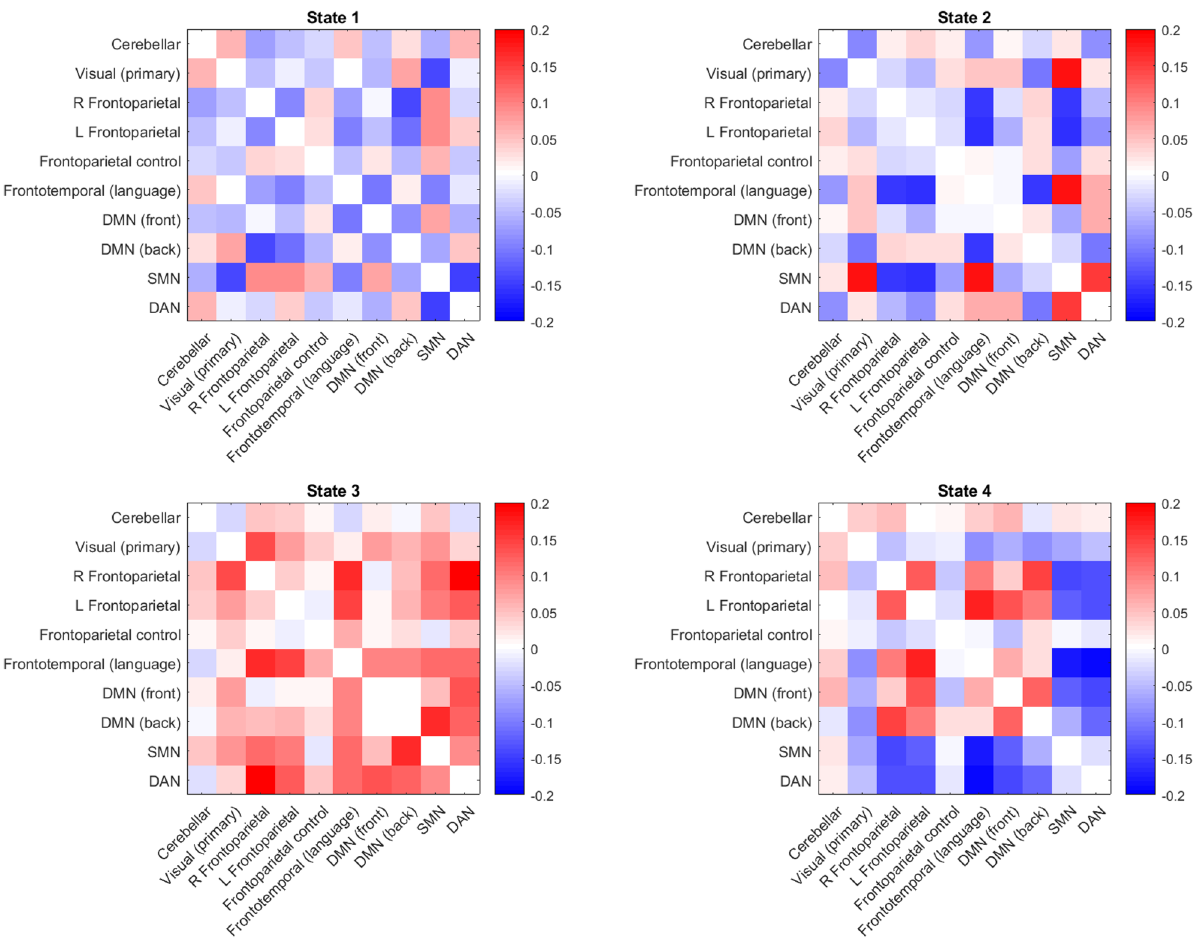
Figure 3. Four identified rs-dFC states (1–4 from the upper left to lower right). Each matrix depicts mutual correlations between each component identified using the ICA. Dark blue suggests a high negative correlation, and dark red suggests a high positive correlation. Note: DMN default-mode network, SMN sensorimotor network, DAN dorsal attentional ity. In state 2, both left and right FPN are anticorrelated with the language and SMN networks. The posterior part of the DMN is particularly anticorrelated to the language network. At the same time, the SMN is highly interconnected with the visual, DAN, and language networks. This state may represent readiness for processing tools and objects, as indicated in the “action reappraisal” concept. This concept suggests that object knowledge is constituted by information inscribed within the motor and sensory systems thus stressing the automatic lower- level processing of information 104 . State 3 is a hyperconnected state which reveals particularly tight connection between the right FPN and DAN, visual and language networks. The (posterior) DMN is highly correlated with the SMN. The state may thus represent readiness for both motor and visual attention reaction to salient stimuli. In state 4, the left FPN (where the tDCS anode was positioned) is highly correlated with the language network which is in turn anticorrelated with the SMN and DAN. This state may represent readiness for top-down control of object identification with an involvement of temporal regions of the ventral visual pathway, and covert verbali- zation/naming of an identified object with an engagement of semantic language processing.